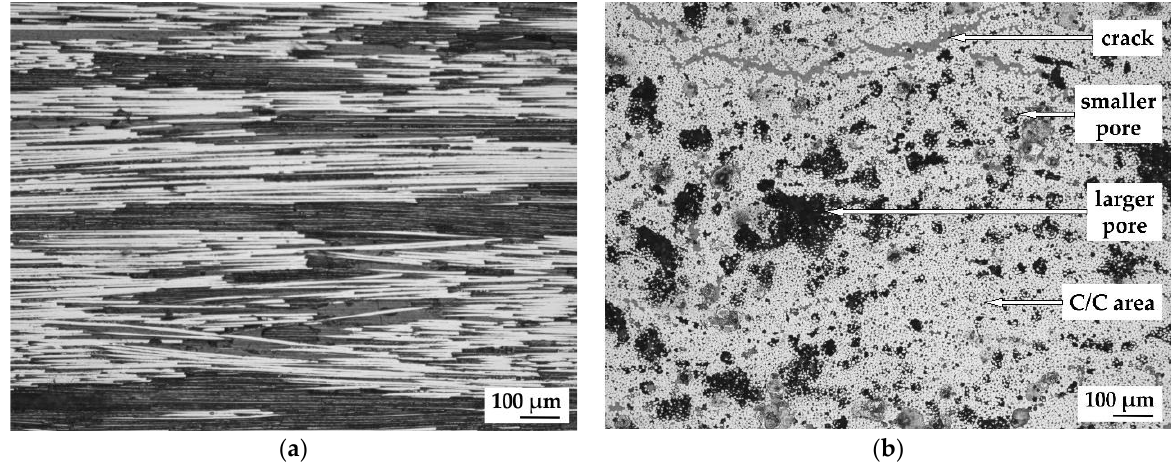
Figure 7. Microstructure of the C/C composite (light microscopy, bright field): ( a ) longitudinal section; ( b ) cross section (light color: fiber areas; dark color: pores; gray: cracks filled with epoxy-embedding material).